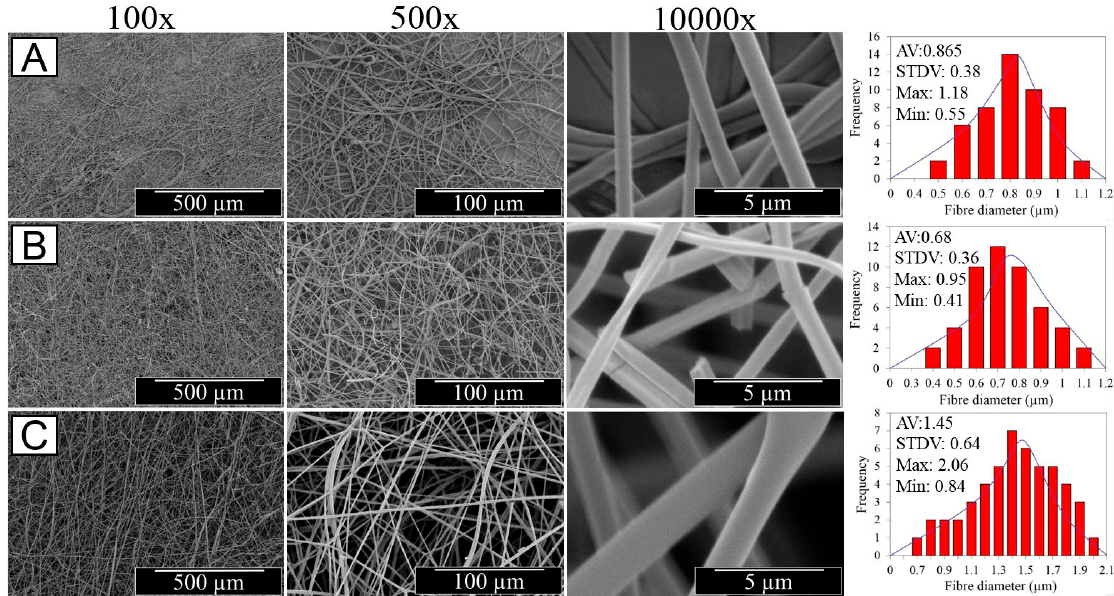
Figure 3. SEM images of PAA fibres following either free surface electrospinning ( A ) or thermally ‐ crosslinked network formation ( B ), as well as of BTB ‐ loaded PMMA ‐ co ‐ MAA fibres ( = 10 cm ∙ min − 1 ) ( C ) at different magnifications. Respective averaged fibre diameter and standard deviation, as well as maximum and minimum fibre diameters are also provided (see Supplementary Material Figures S2– S7).